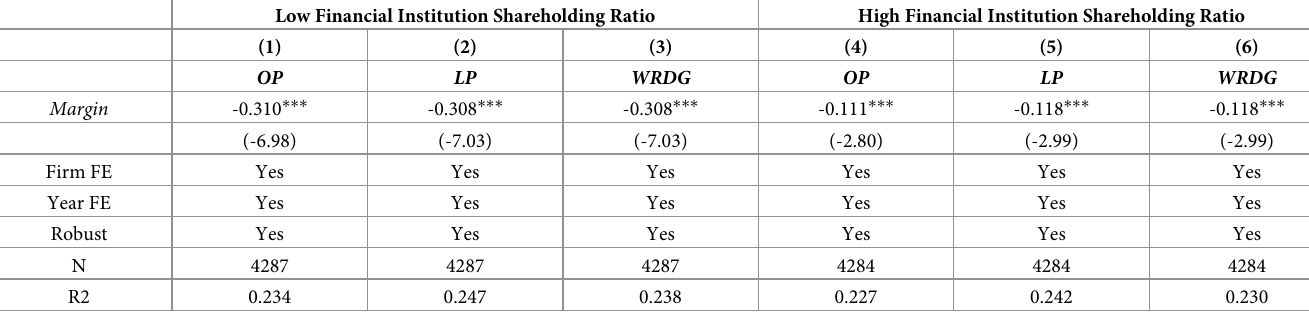
Table 9. Cross-sectional analysis of different financial institution shareholding